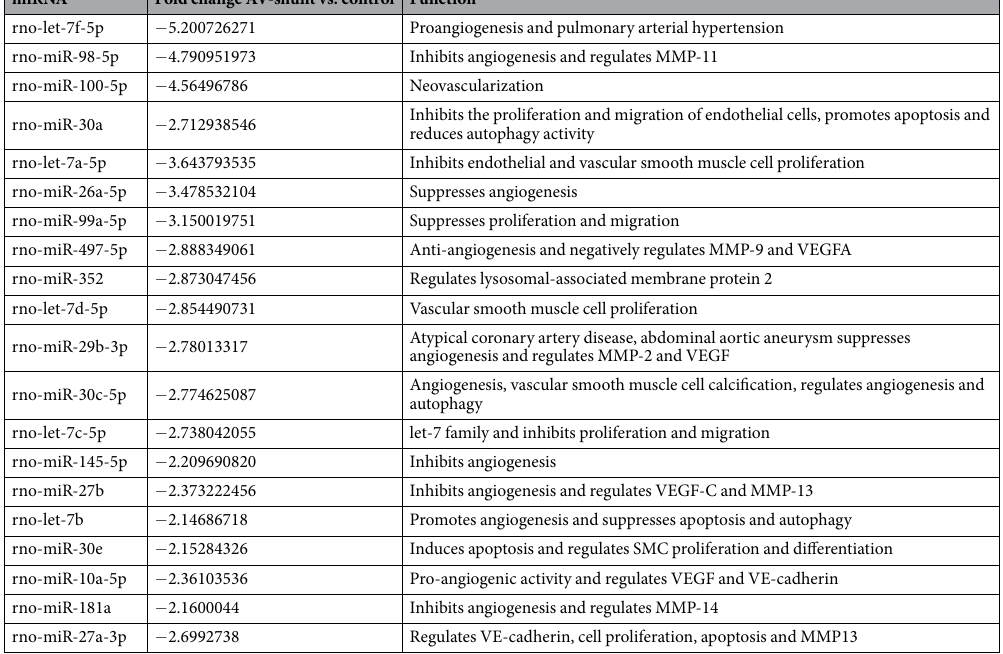
Table 2. Twenty down-regulated